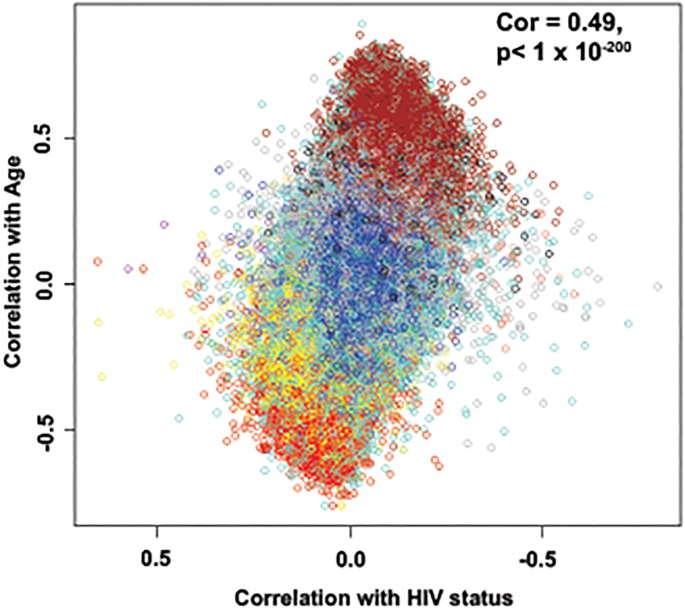
Age effects versus HIV-1 effects on methylation status.Methylation differences for each of the 24 pairs of samples were calculated and a paired t-test was performed for each of the CpG sites on the 450K array. The HIV-1 effect (X-axis) was measured as the signed logarithm of the Student t-test p-value. Age effects (Y-axis) were measured by the Pearson correlation coefficient with age. Each dot is colored according to its module membership (See Fig. 2). This is a representative figure for both data sets.